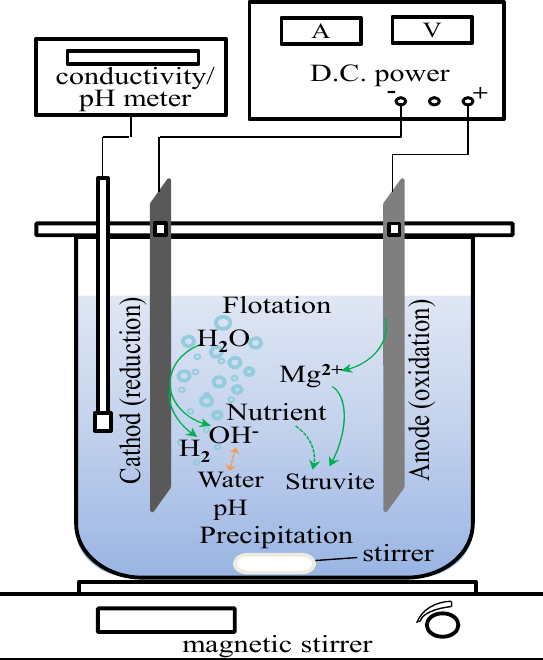
Figure 1. Schematic diagram of experimental set-up.